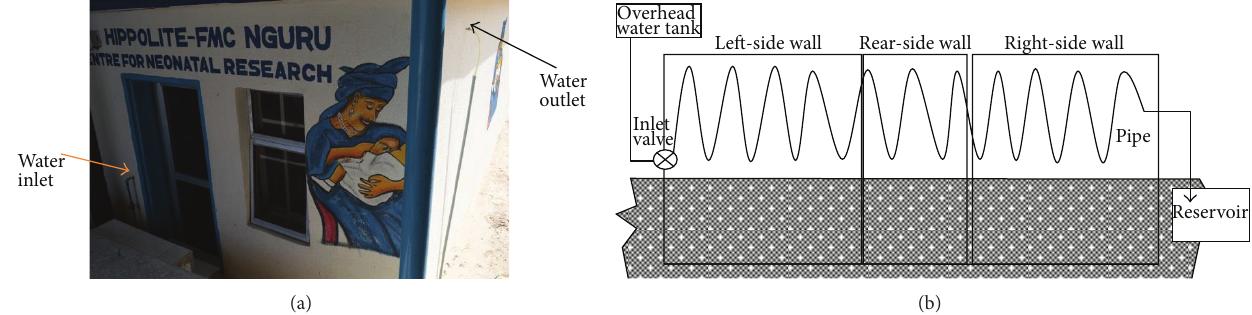
Figure 2: (a) Lab-1 showing heat exchanger water inlet and outlet. (b) Heat exchanger copper piping through the walls of Lab-1. Overhead tank delivered water through an inlet valve. Circulation was ensured automatically through the positive pressure head created by the relative height of the overhead tank. Cool water in the under-surface reservoir was pumped back to overhead tank when